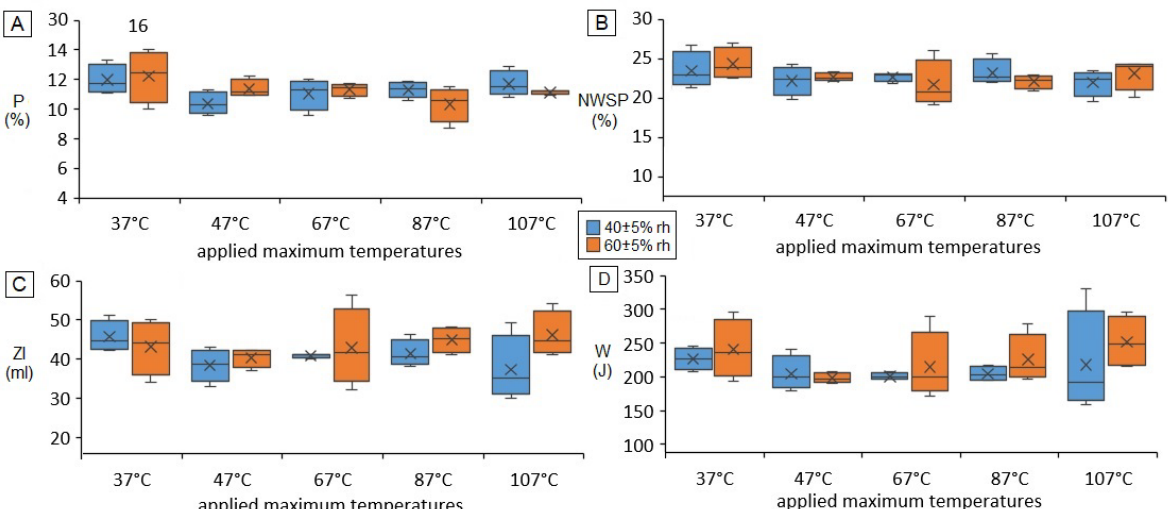
Figure 4. Quality parameters of wheat heated at different maximum temperatures: ( A ) total protein content (P), ( B ) water-insoluble protein content (NWSP), ( C ) Zeleny index (ZI), and ( D ) alveograph deformation energy (W).